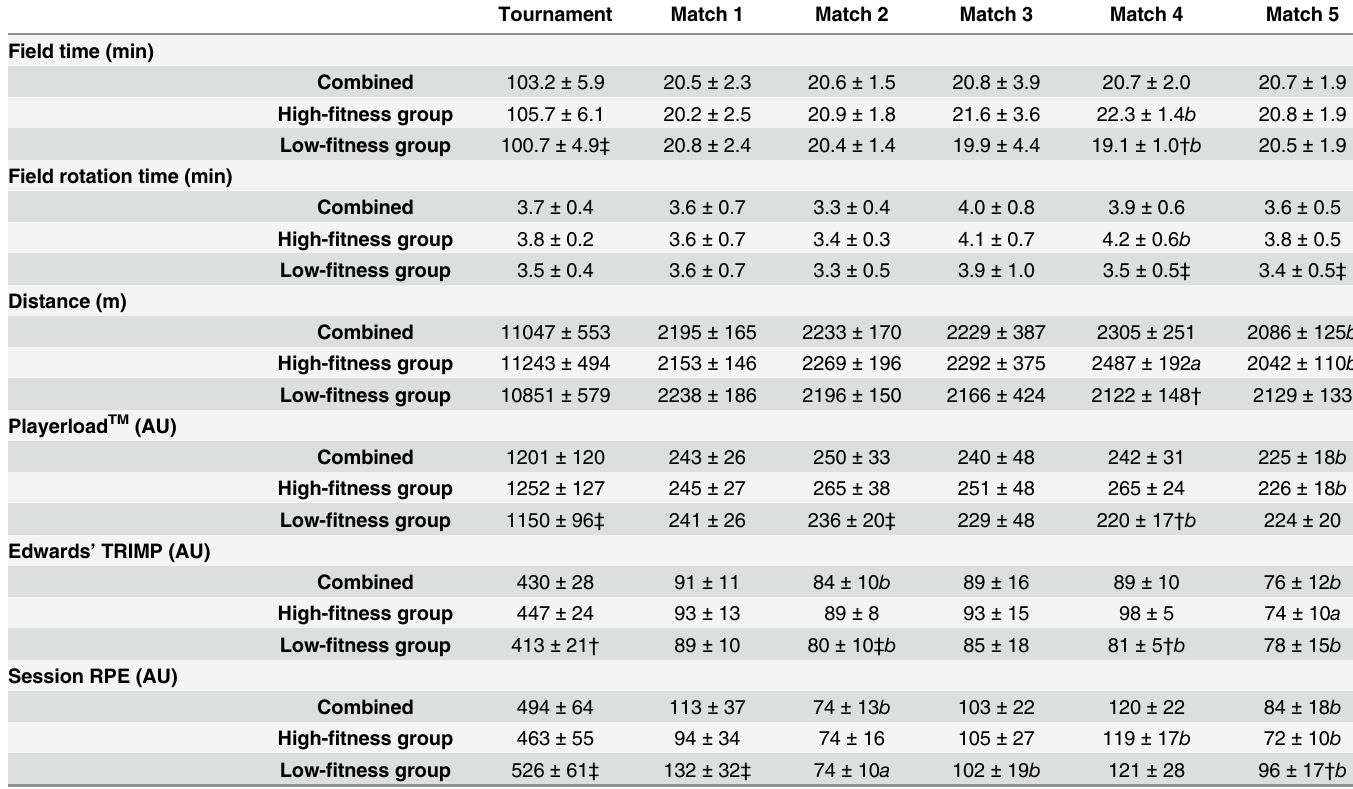
Table 2. Tournament and match workloads for tag football players grouped into high- and low-fitness